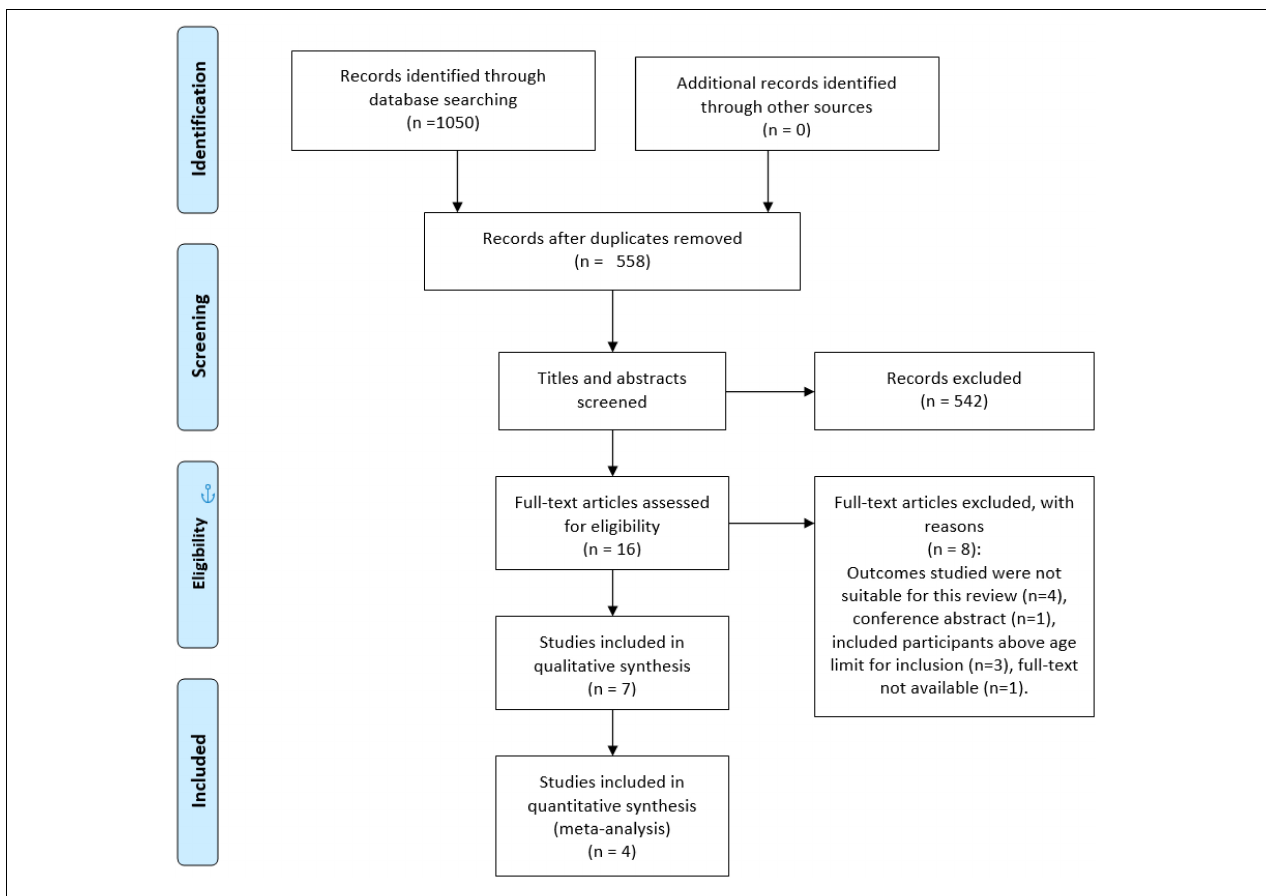
FIGURE 1 | PRISMA flow